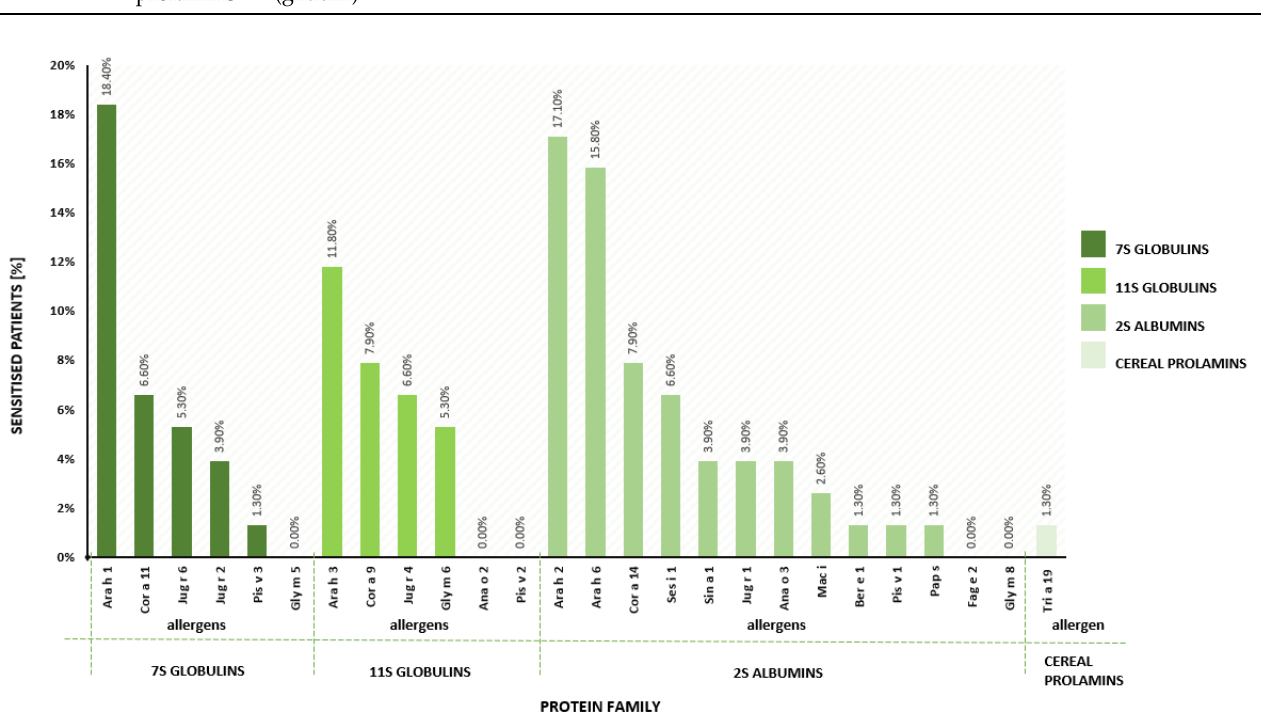
Figure 2. Prevalence of sensitisation to 26 allergenic molecules in atopic children aged 0 – 5 years.